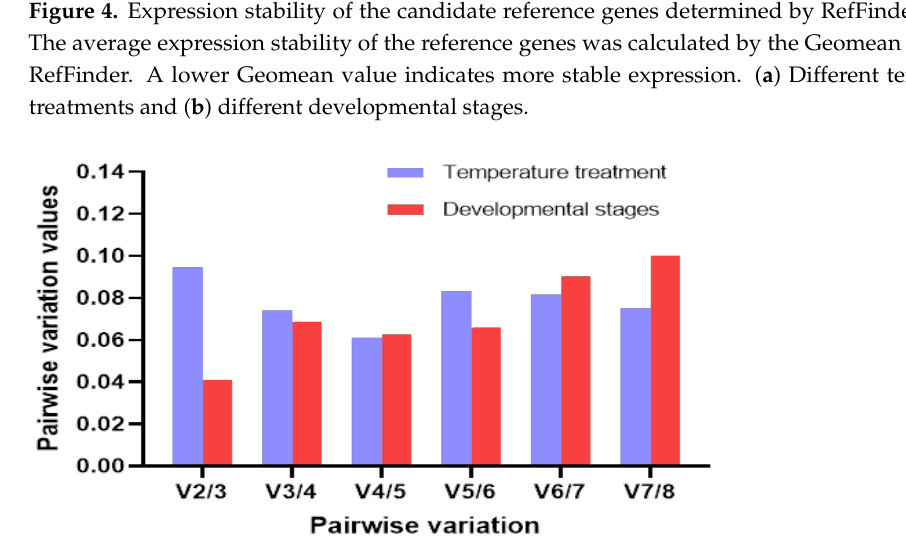
Table 2. Stability of eight candidate reference genes expression in B . xylophilus under different ex- perimental conditions.